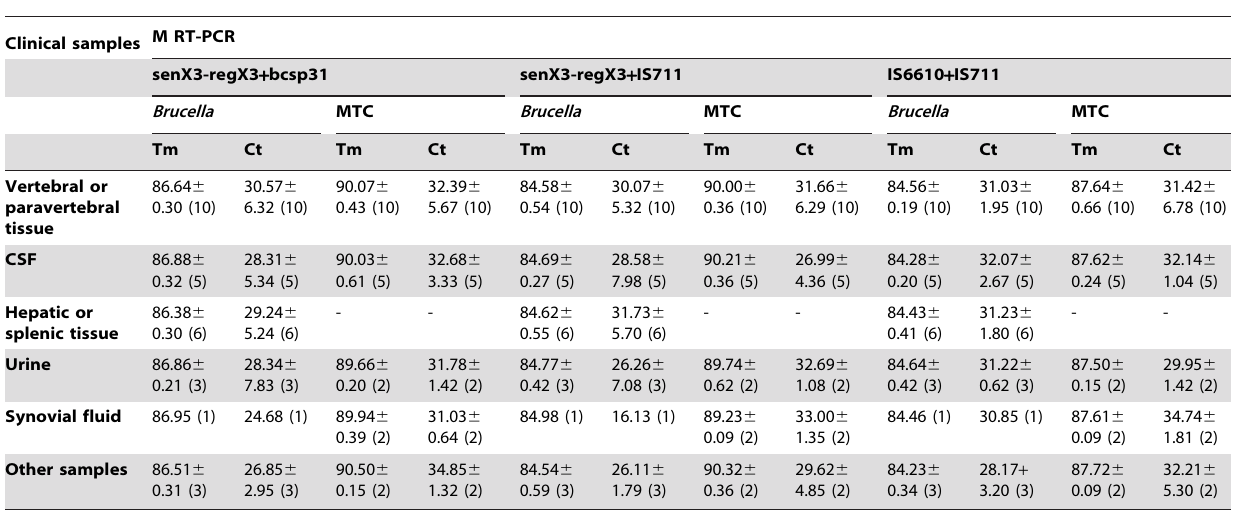
Table 5. Tm ( u C) and Ct (cycle) values with the three strategies of M RT-PCR studied by type of clinical sample.